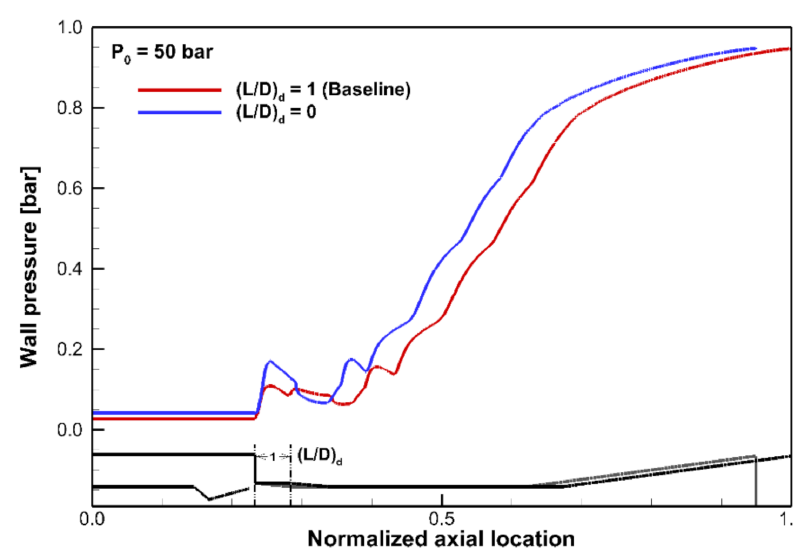
Figure 9. Wall pressures of two diffuser entrance length